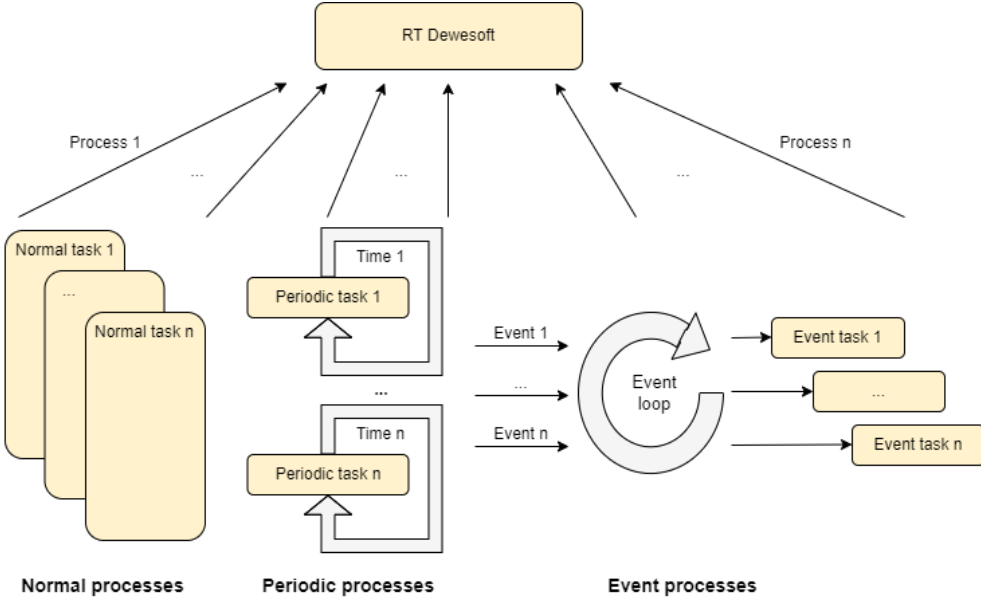
Figure 5. Multi-process architecture of an